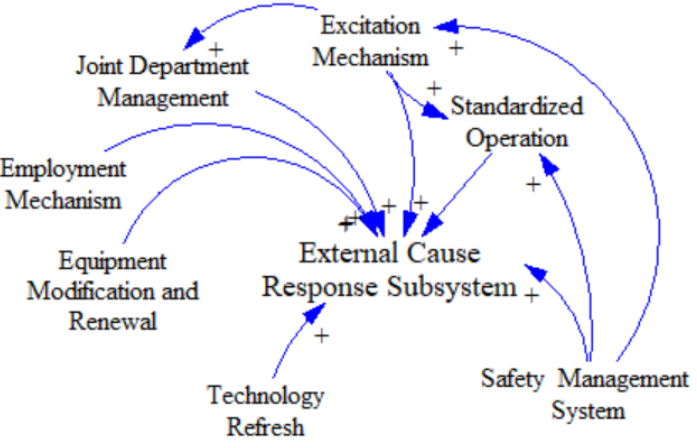
Figure 9. External response causal diagram of G H